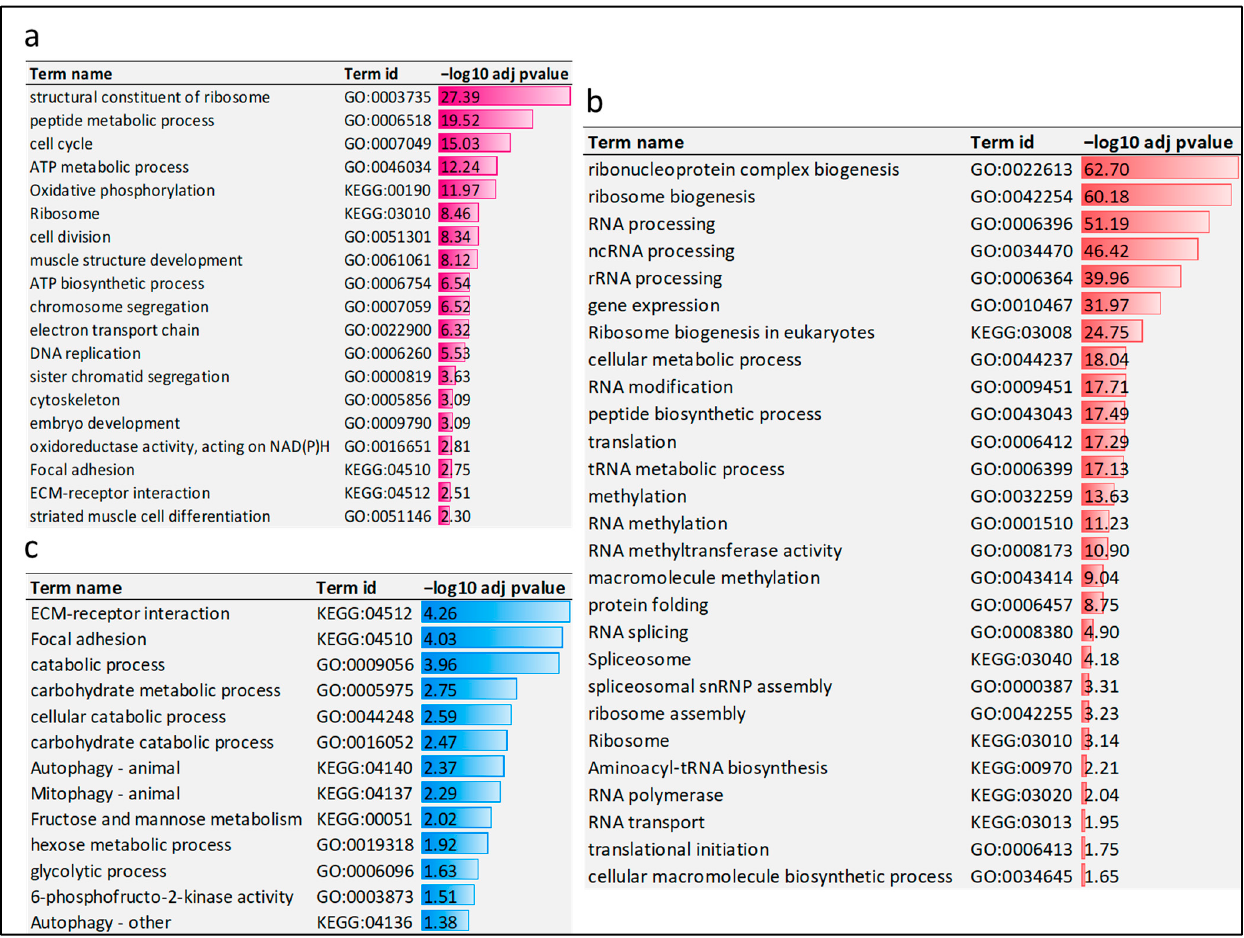
Figure 6. Functional enrichment analyses. ( a ) Enrichment analysis of transcripts whose expression levels in refed fish were restored to normal levels (first cluster). Enriched KEGG pathways and GO terms are represented in purple. ( b ) Enrichment analysis of transcripts whose expression levels in refed fish exceeded normal growth values (second cluster). Over-represented KEGG pathways and GO terms are represented in red. ( c ) Enrichment analysis of transcripts whose expression levels in refed fish did not reach normal growth values (third cluster). Under-represented KEGG pathways and GO terms are represented in blue. Negative log10 of adj p -values are